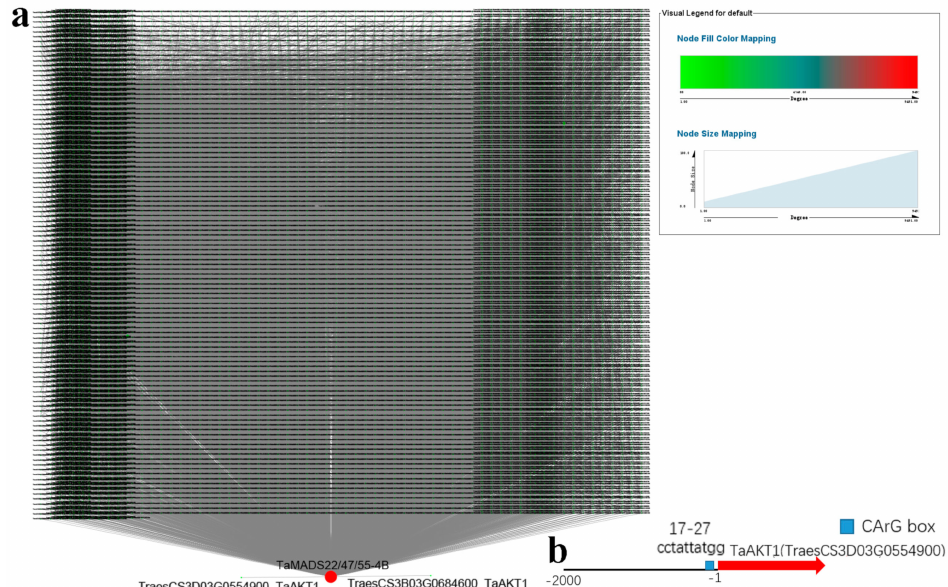
Figure 10. Hub genes identified in ‘darkred’ module. ( a ) Cytoscape representation of relationship of genes (edge weight ≥ 0.10) in ‘darkred’ module, genes with a large and small degree are indicated with large red and small green circles. ( b ) MADS binding cis -element (CArG) box in promoter of TaAKT1